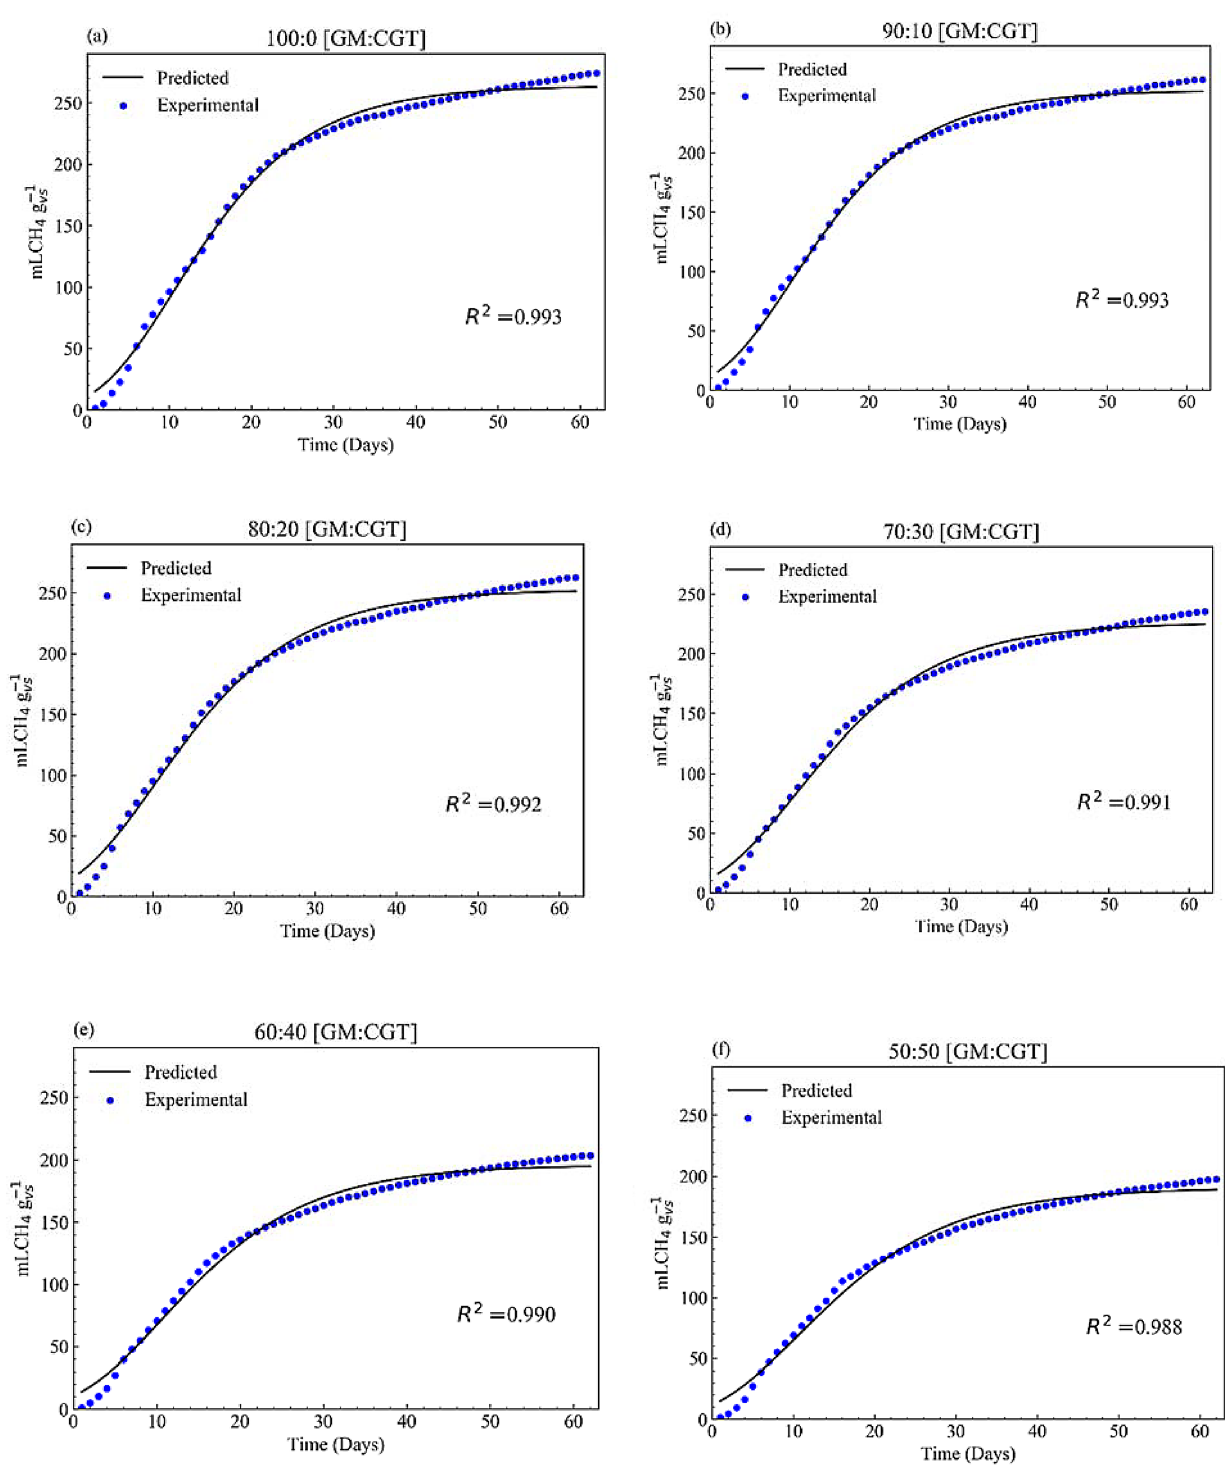
Fig. 2 The modified Gompertz model-simulated and experimental biomethane yields (mL/g of goat manure (GM) and cotton gin trash